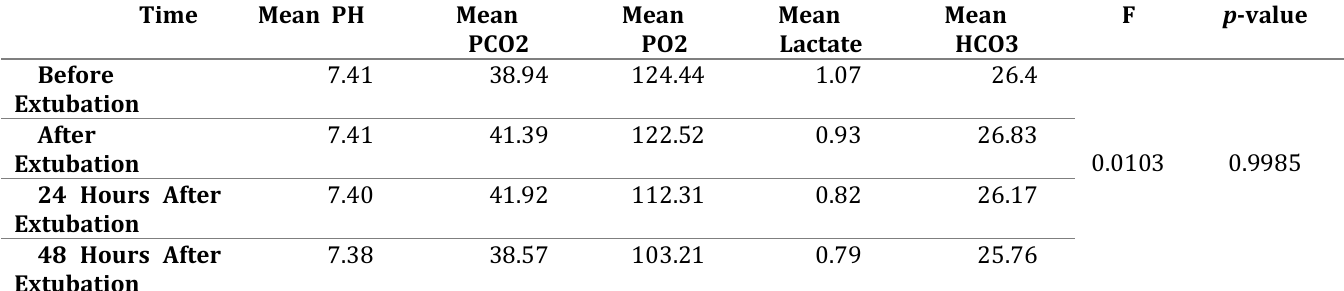
Table 3: Comparison between Arterial Blood Gas of Pre & Post Extubated patients